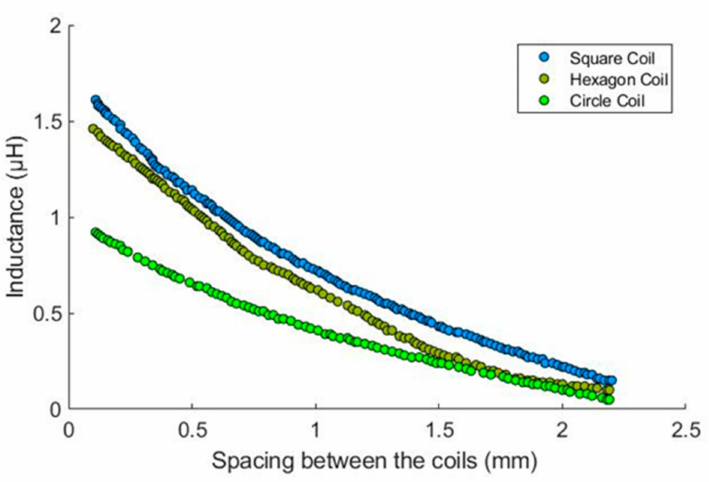
Figure 6. The simulation results of varying the spacing distance between excitation and the sensing